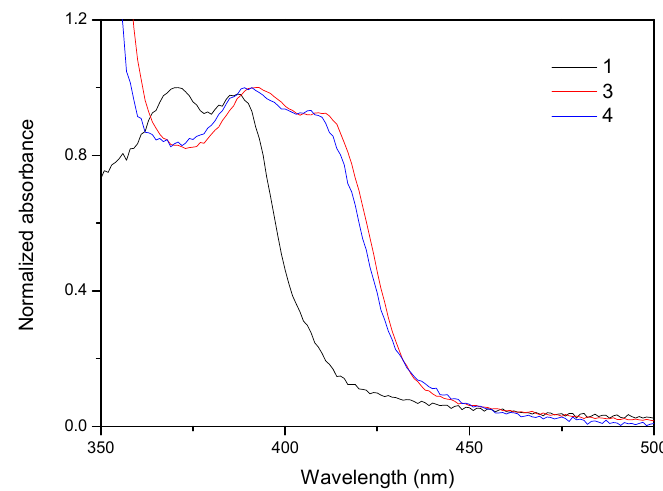
Figure 1. Normalized absorption spectra of 1 × 10 − 5 M solutions of both complexes 3 and 4 and the free ligand 1 in dichloromethane.